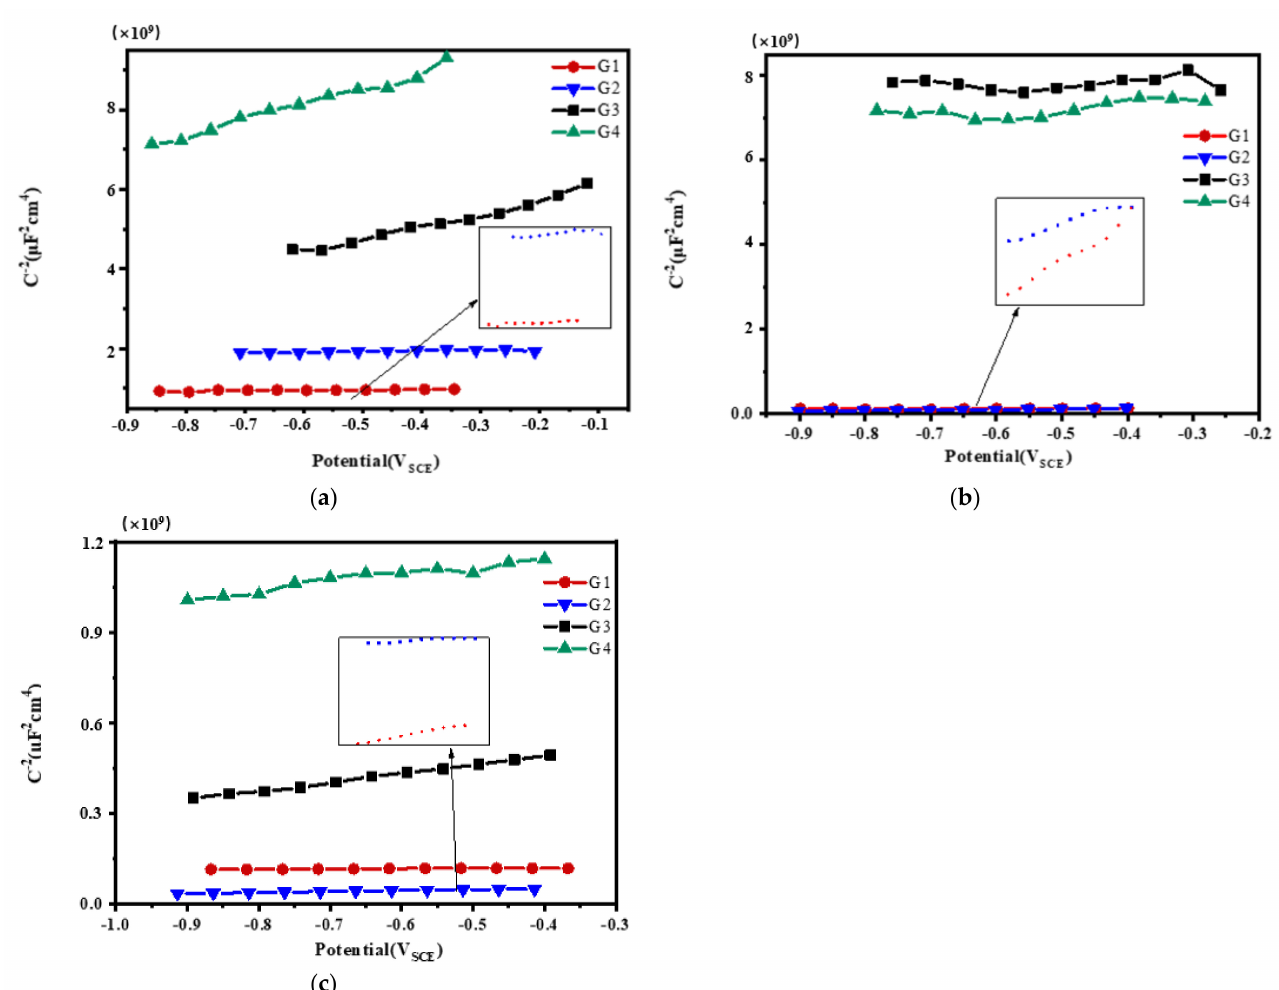
Figure 12. Each coating’s Mott–Schottky pattern for immersion for 15 days: ( a ) 20% Seawater; ( b ) 40% Seawater; ( c ) 60%